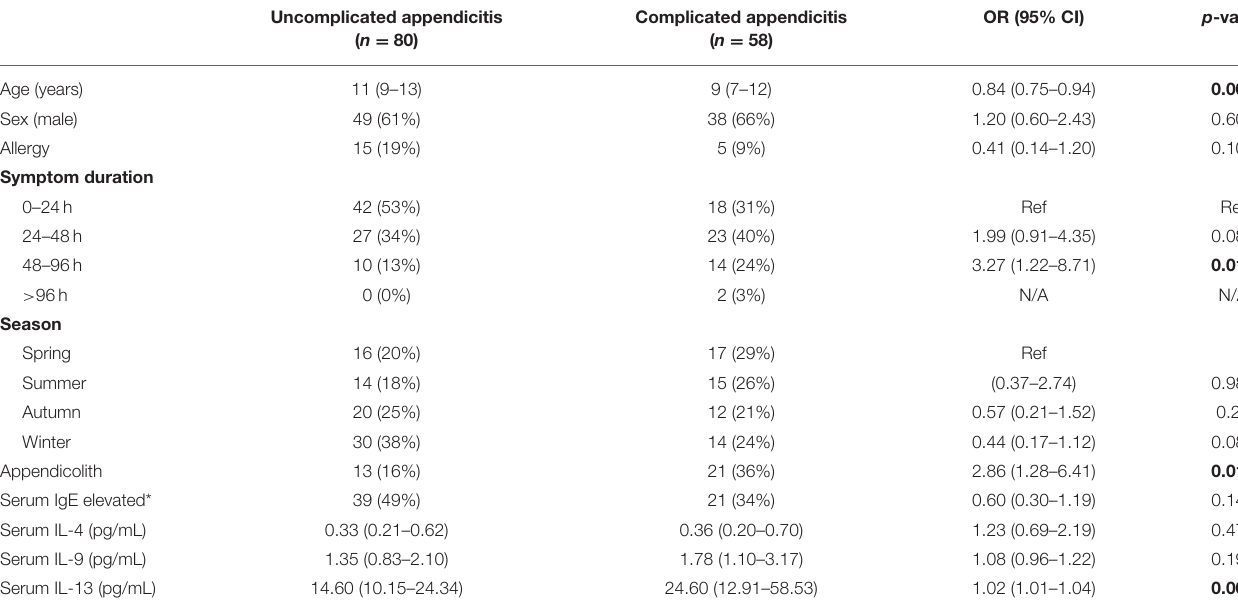
TABLE 3 | Unadjusted independent variables of complicated appendicitis in 138 children with appendicitis. Uncomplicated appendicitis ( n = 80)